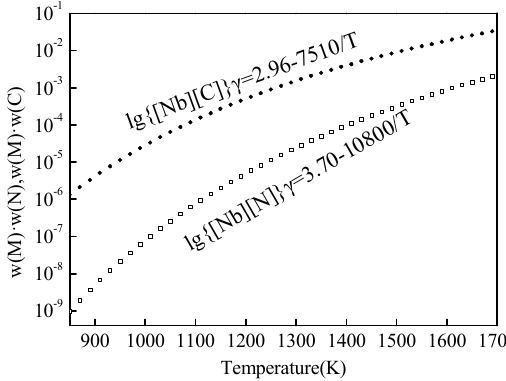
Figure 19. Solubility product of carbide or nitride for Nb in austenite.